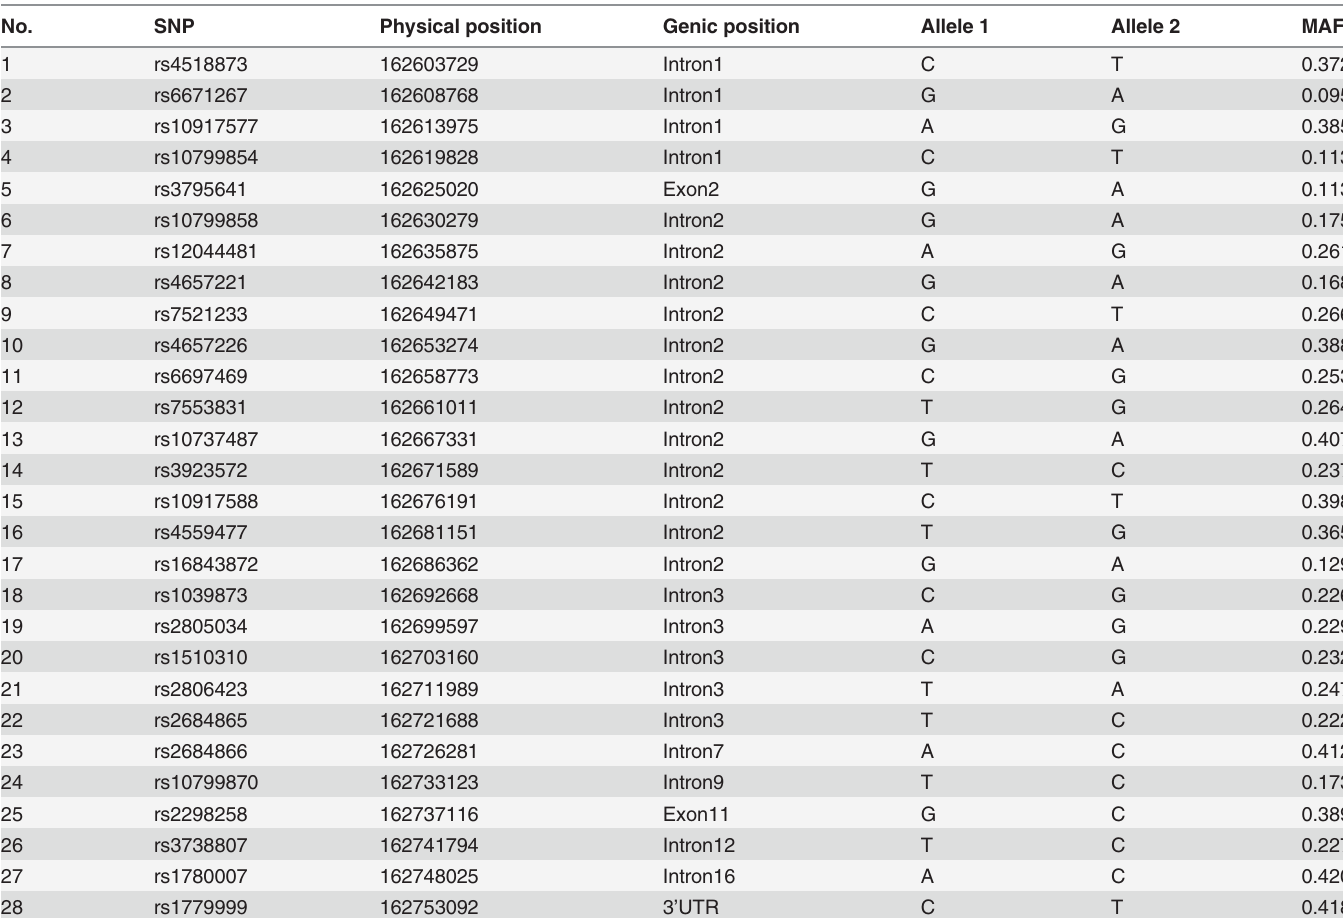
Table 2. Properties of all SNPs in DDR2 tested in this